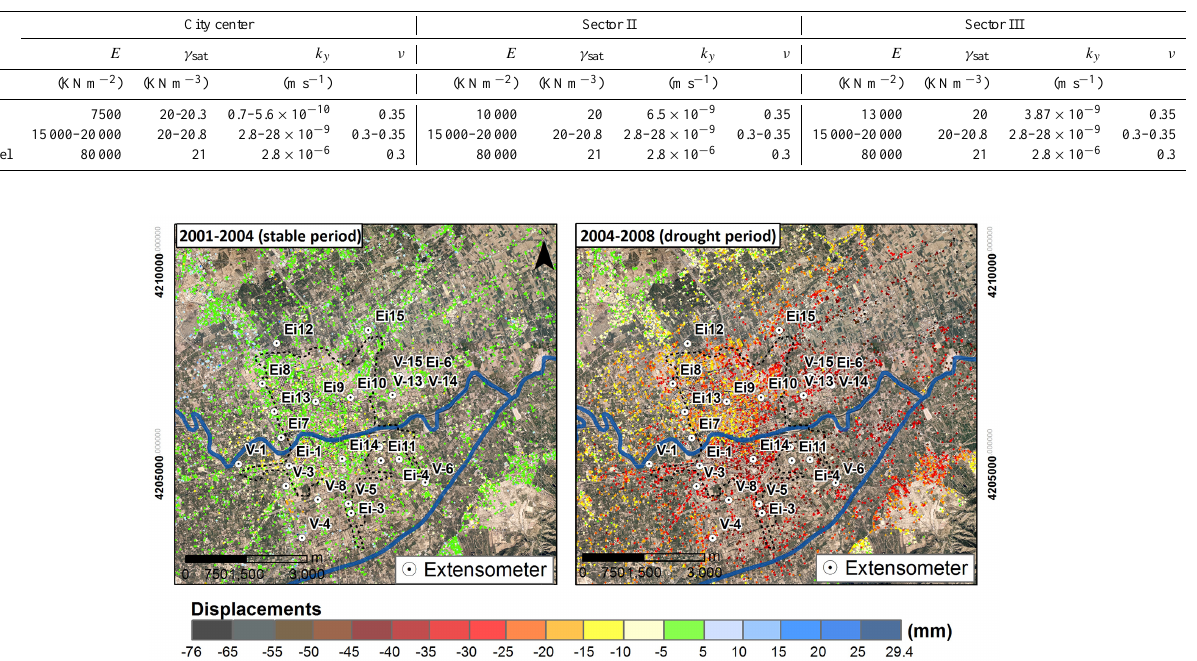
Figure 2. Cumulated DInSAR vertical displacement over two time periods: 2001–2004 (stable) and 2004–2008